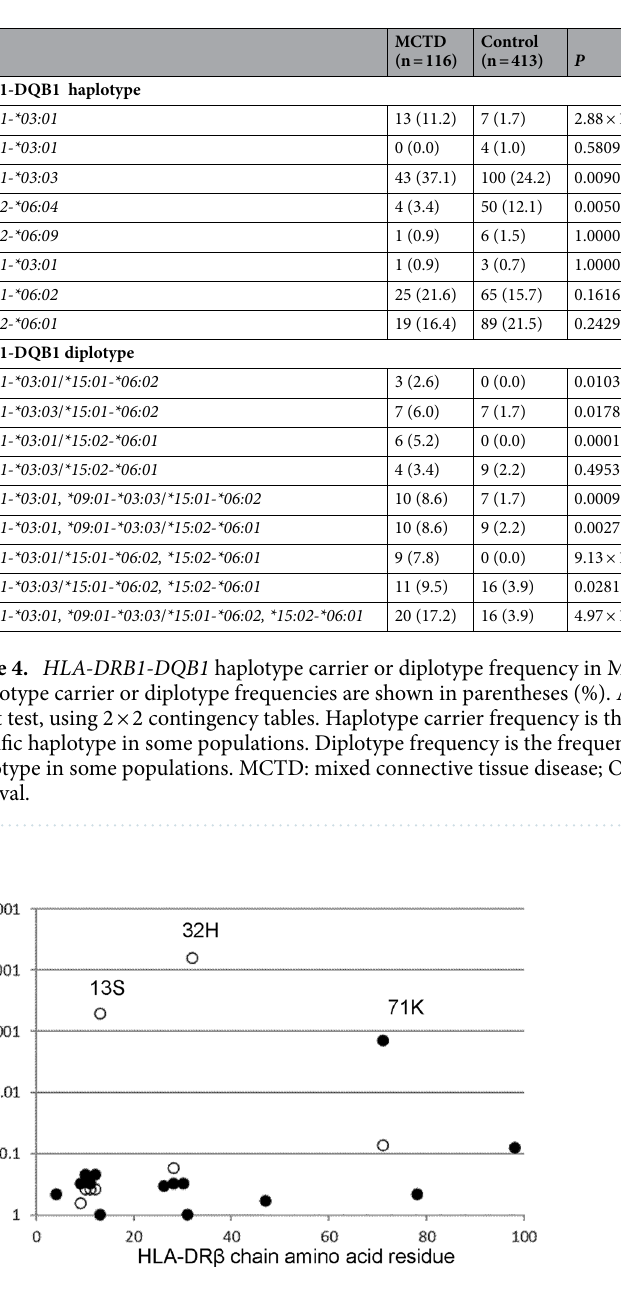
Figure 1. Associations of amino acid residues in the DRβ chain with MCTD. Significance of the associations was established by Fisher’s exact test, using 2 × 2 contingency tables. Corrected P ( P c) values were generated by multiplying P values by the number of analyzed amino acid residues. Predisposing associations are indicated by filled circles and protective associations by open circles. MCTD: mixed connective tissue